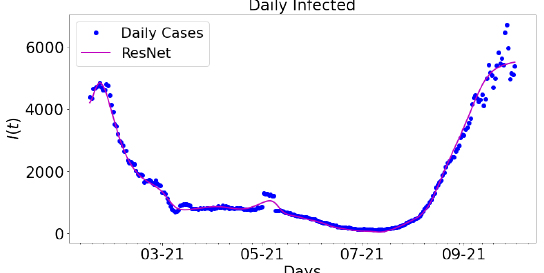
Figure 12. Data-driven simulation for real COVID-19 data and ResNet.